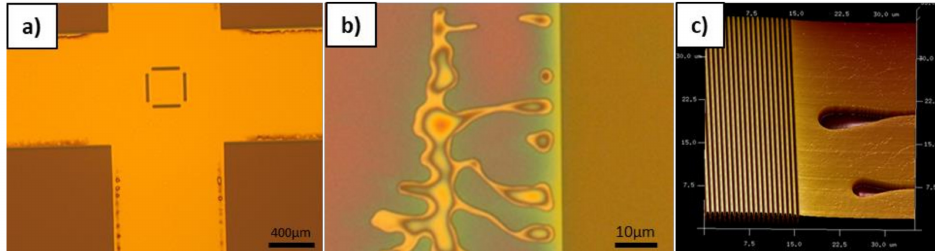
Figure 9. ( a ) Optical microscope image of imprinted L/S arrays (dark) and non-pattered areas (bright), ( b ) detail optical microscope image of defects occurring due to too low resist volume, and ( c ) AFM image of the imprinted L/S pattern showing the neighboring